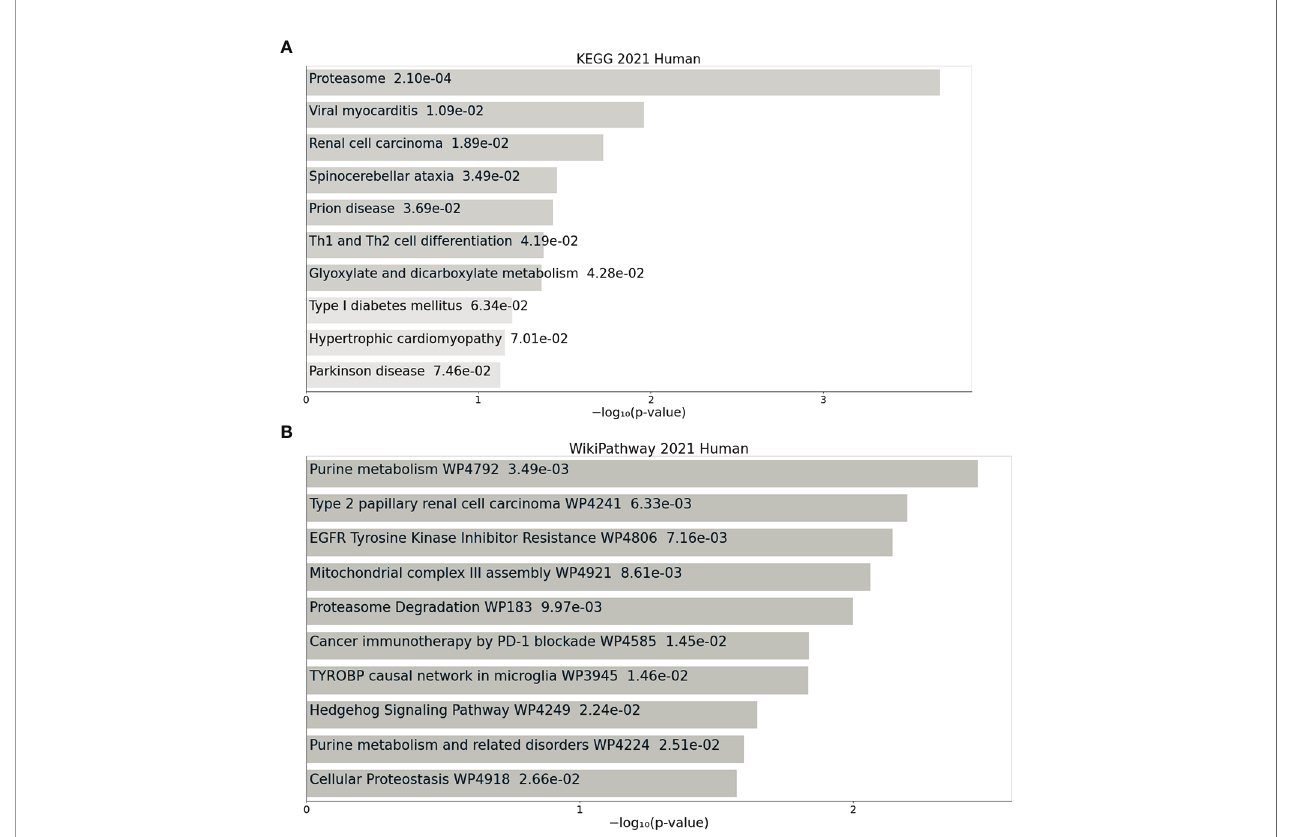
FIGURE 5 | Pathways equally expressed in ccRCC primary cell cultures and the tissue of origin. (A) Enrichr analysis revealed that primary cell cultures shared the same mRNA expression levels of pathways involved in proteasome, renal cell carcinoma, several other diseases and glyoxylate and dicarboxylate metabolism (KEGG 2021 Human pathways). (B) The primary cell cultures furthermore displayed a very similar expression of genes regulating purine metabolism, resistance mechanisms against EGFR tyrosine kinsase inhibtors and cancer